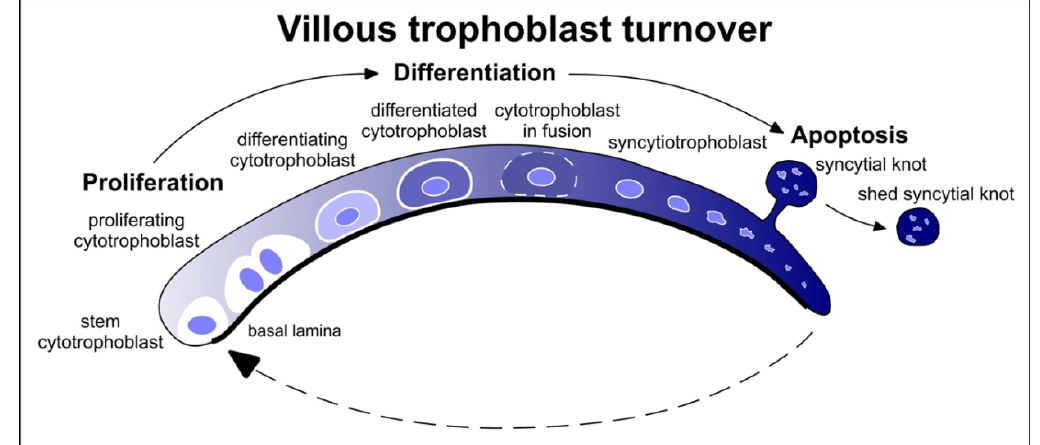
Figure 8. Turnover of cells that make up the villous trophoblast is essential for proper functioning of the placenta. Proliferative cytotrophoblast stem cells differentiate and eventually exit the cell cycle. These cells then fuse to form a multinucleated syncytium, the syncytiotrophoblast. Within several days cells of the syncytiotrophoblast undergo apoptosis. The additions of differentiated cytotrophoblasts replace the syncytiotrophoblast cells that are lost via apoptosis. The apoptotic loss of the syncytiotrophoblast is balanced by the fusion of differentiated cytotrophoblast cells. Locally produced melatonin seems to be involved in maintenance of homeostasis by limiting apoptosis of the differentiated cytotrophoblasts while enhancing apoptosis of the syncytiotrophoblast; these latter cells have characteristics of cancer cells in which melatonin also causes apoptosis. From Lanoix et al.